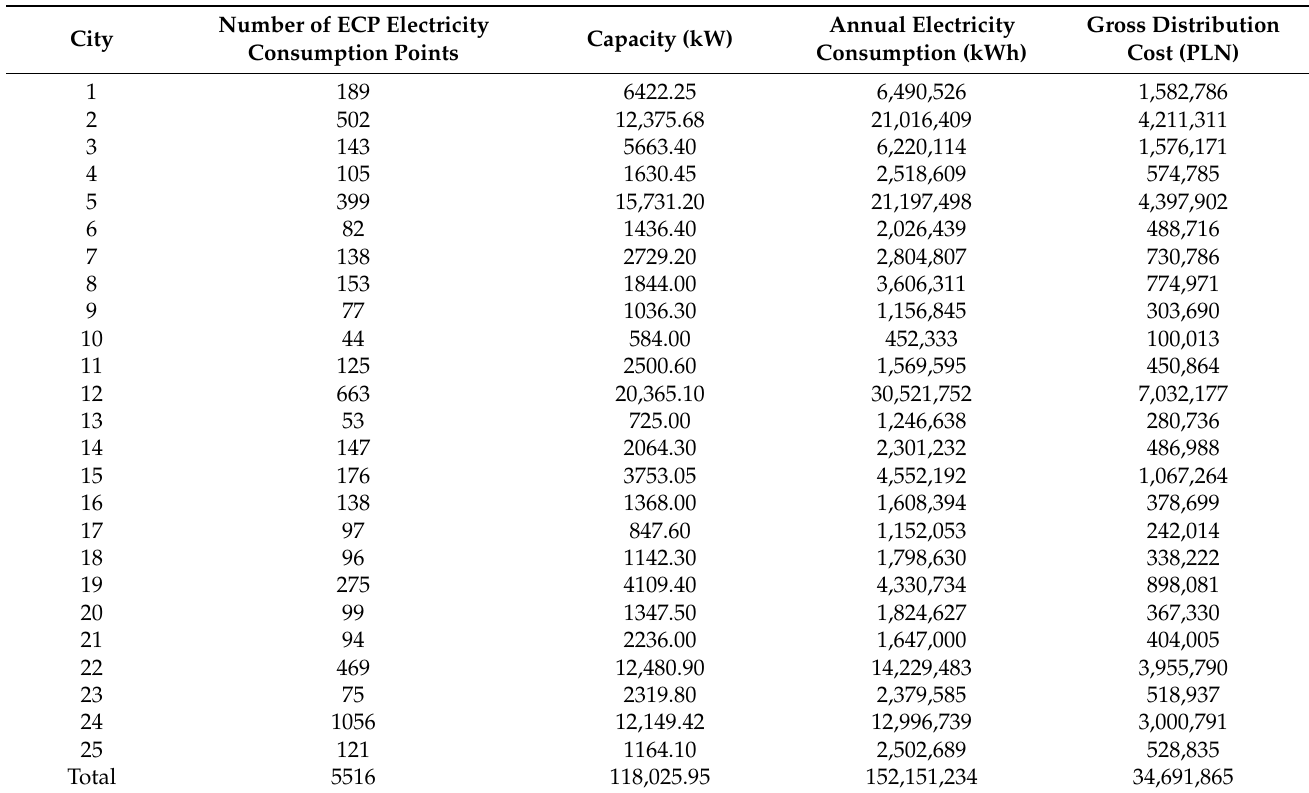
Table 1. Electricity distribution costs analysis—summary of input data.